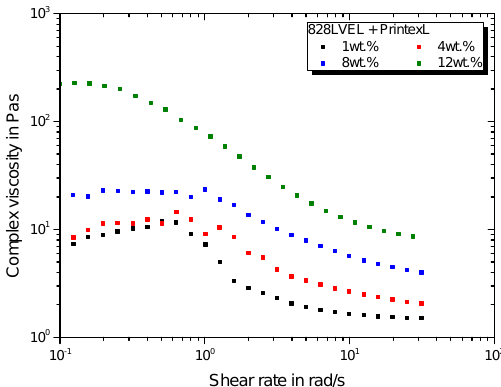
Figure 4. Rheological behavior of CB modified 828LVEL and RIMH137/134.